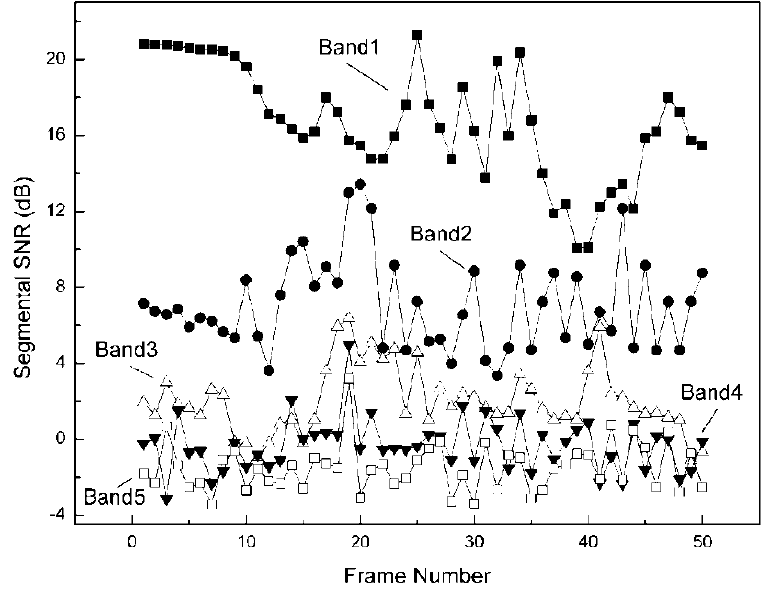
Figure 1. The segmental SNR of five frequency bands of EL speech.